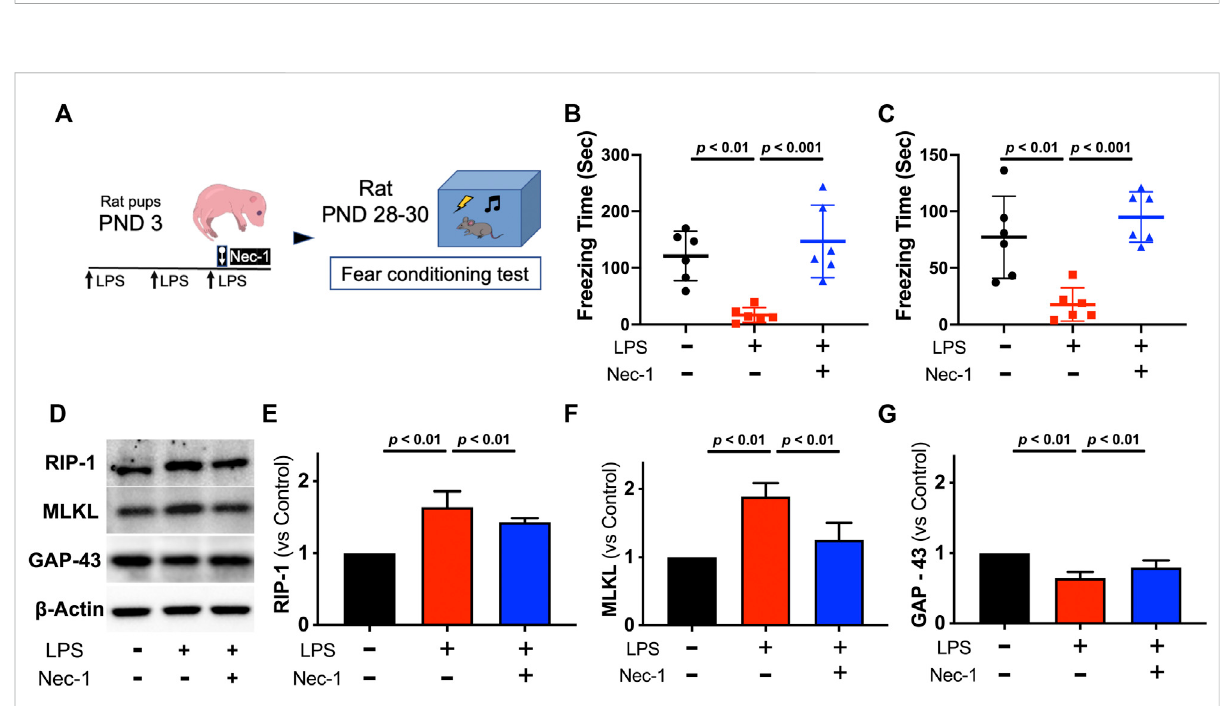
FIGURE 4 Necrostatin-1 also improved cognitive function and prevented necroptosis activation in juvenile rats with neonatal LPS administration. Study Scheme (A) .Freezingtime forcontexttest (B) andcue-tonetest (C) tested 26daysand27 daysafter initialLPSinjection,respectively. Representative western blot images (D) with quanti fi cation (E – G) for necroptosis from the hippocampus. Data are expressed as mean ± SD Data are expressed as mean ± SD. (Nec-1 = necrostatin-1; n = 6 in each